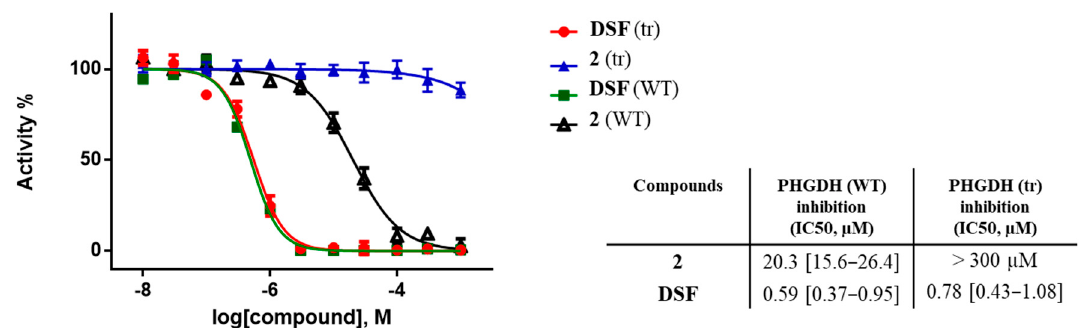
Figure 7. Dose–response curves of compounds 2 and DSF on isolated PHGDH (WT and tr). IC 50 values were determined from two independent experiments performed in triplicates at each compound dilution, in brackets: 95% confidence in- terval.